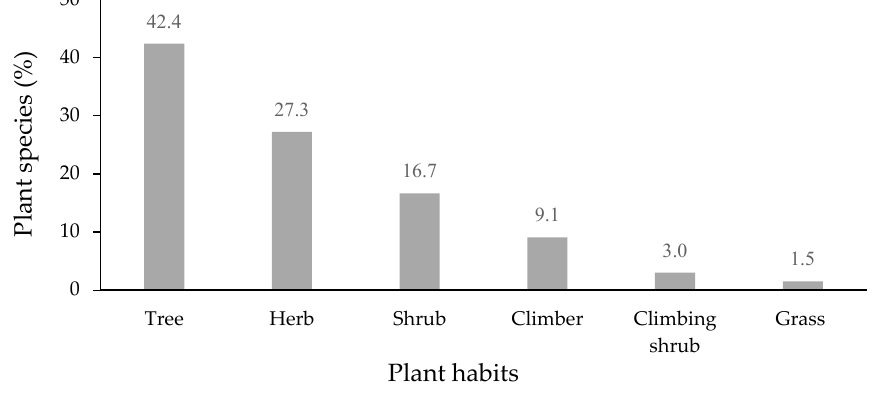
Figure 3. Habit of plants in polyherbal remedies used for the treatment of skin diseases ( n = 66). Sixteen different plant parts were used in the polyherbal formulations for skin infection. Leaves were the most frequently used part (20.9%), followed by roots (16.4%), rhizomes (9.0%), seeds (9.0%), and stem bark (9%). The rest of the parts used of the plants are